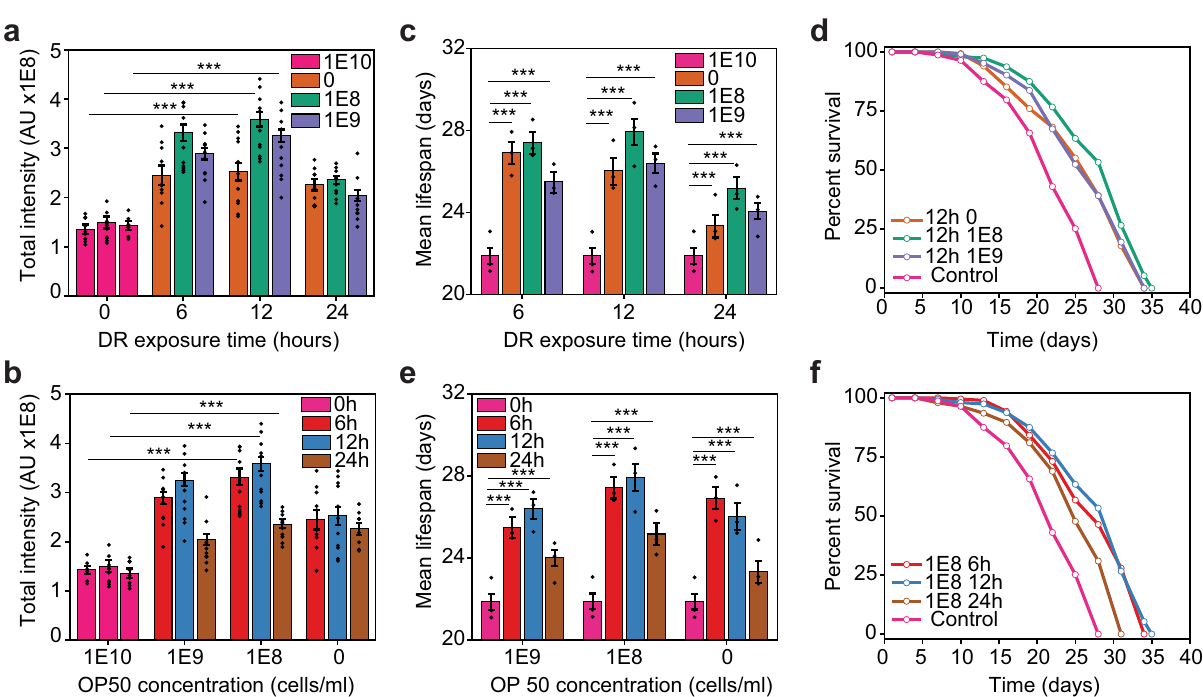
Fig. 2 DR regimes modulate endogenous DAF-16 activity. a DAF-16 total intensity as a function of exposure time to DR for various food concentrations at Day 1 of adulthood. b DAF-16 total intensity as a function of food concentration for various exposure times at day 1 of adulthood. c Mean lifespan as a function of exposure time at various food concentrations. d Lifespan curves for populations under various food concentrations with 12 h of exposure to DR. e Mean lifespan as a function of food concentration at various exposure times. f Lifespan curves for populations under various exposure times to DR with a 10 8 OP50 cells/ml food concentration. p < 0.001 (***). Error bars are SEM. All p -values were calculated using Tukey HSD for all pairwise comparisons after one-way ANOVA (unequal variances) comparison. Control population (pink) is ad libitum (1E10 cells/ml, 0 h exposure